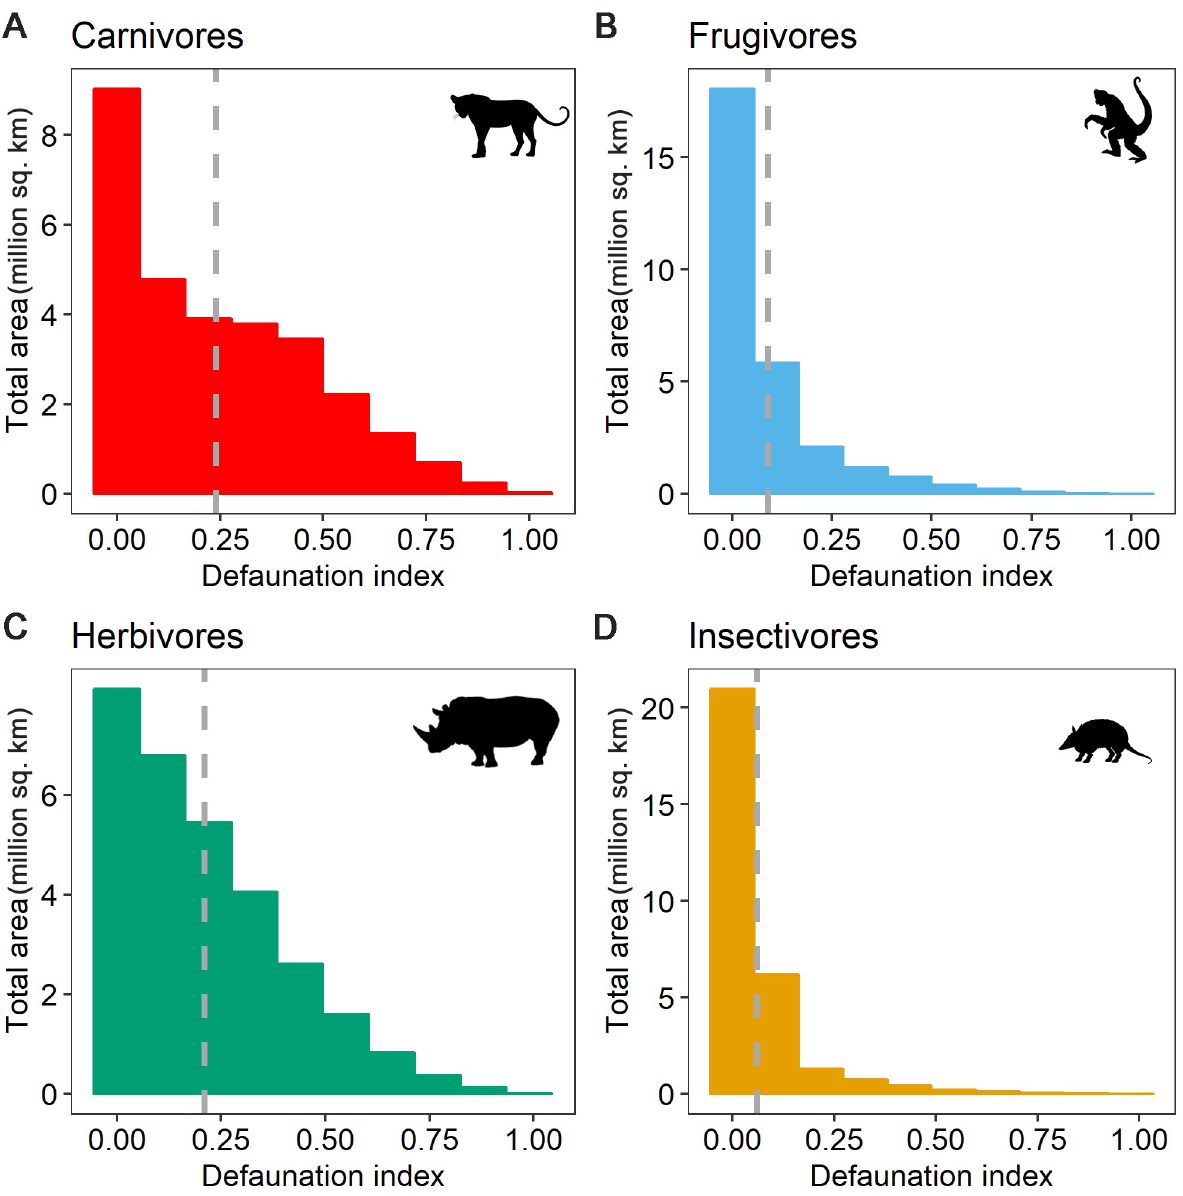
Fig 3. DI for different trophic groups: (A) carnivores, (B) herbivores, (C) frugivores, and (D) insectivores. The dashed gray line indicates the mean DI across the pantropical forest zone. The y-axes have different scales. Available at